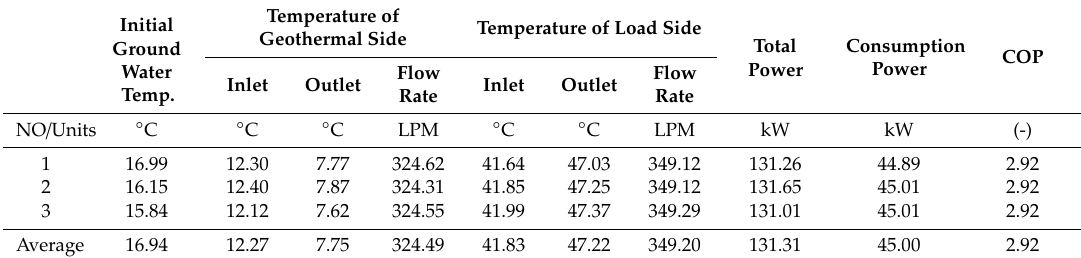
Table 5. Measured results of the SCW geothermal system during heating operation.